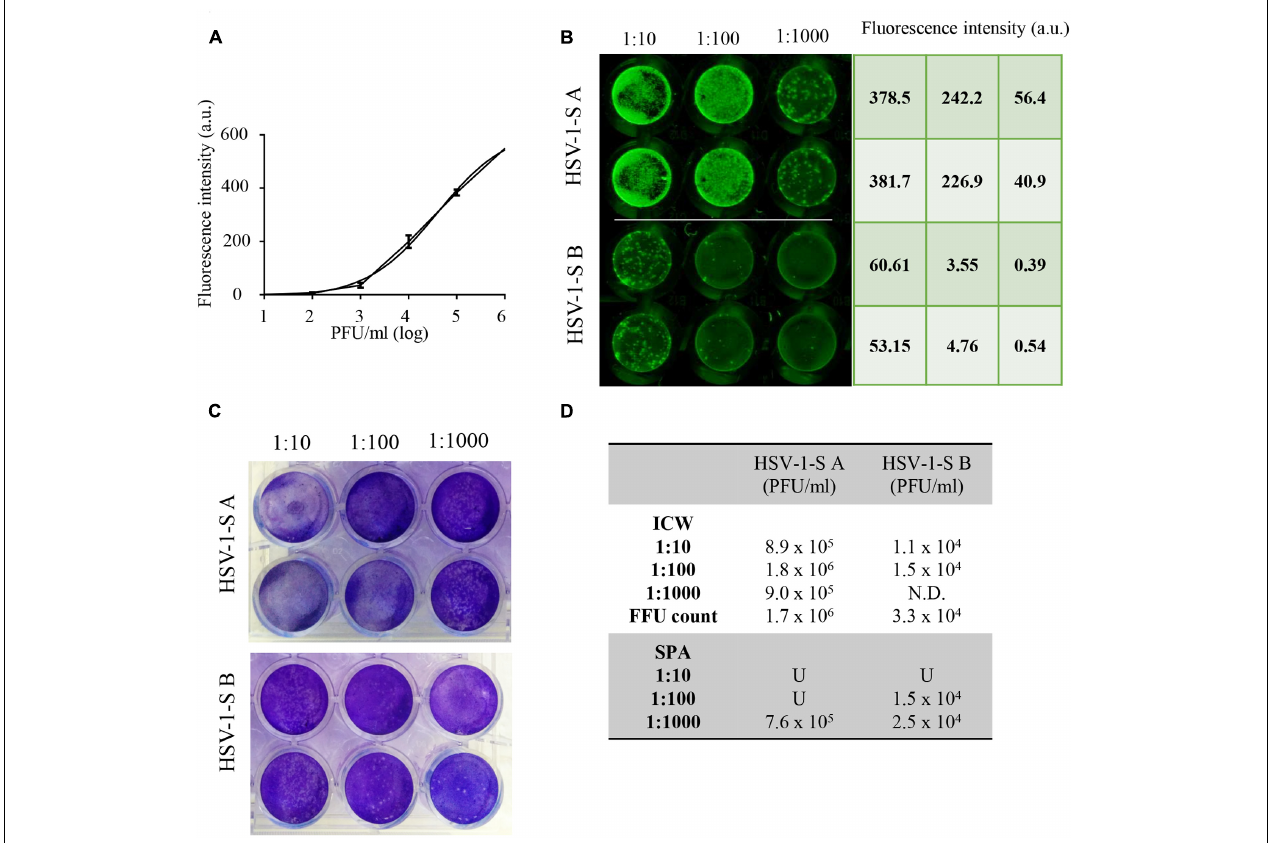
FIGURE 2 | “In-Cell Western TM ” Assay vs. standard plaque assay. (A) ICW Internal standard curve built up by using the mean value of intensity fluorescence detected in Vero cells infected with 10-fold serial dilutions of HSV-1 with a known titre. (B,C) Two unknown HSV-1 samples (HSV-1-SA and HSV-1-SB) were titrated using ICW (B) and SPA (C) as described in Section “Materials and Methods.” (D) Mean values of HSV-1-SA and HSV-1-SB titer for each tested dilution in the two assays. N.D. = not detectable; U =